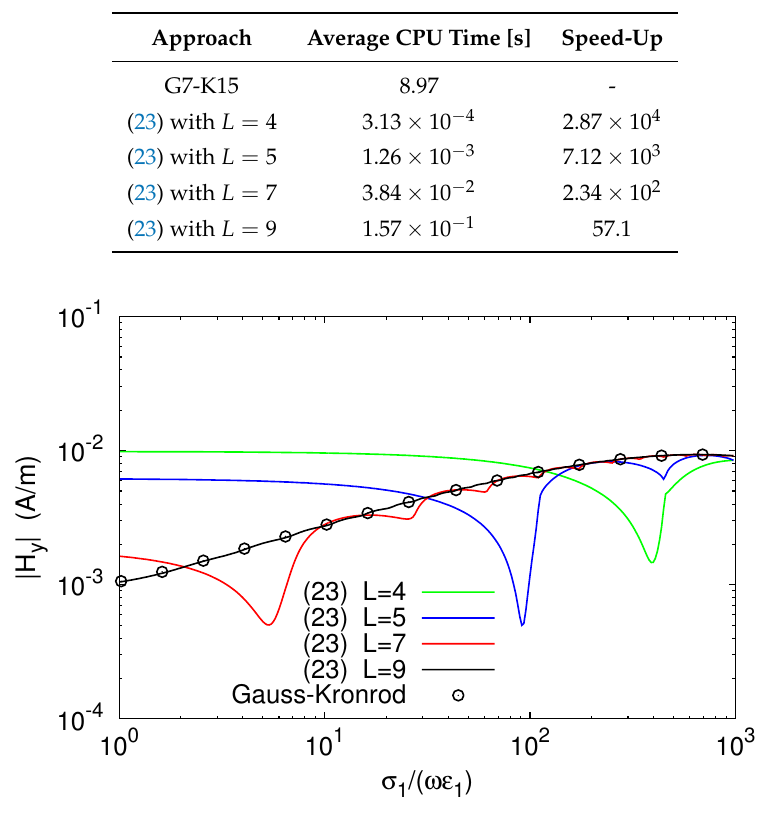
Table 1. CPU time comparisons for the calculation of H y .